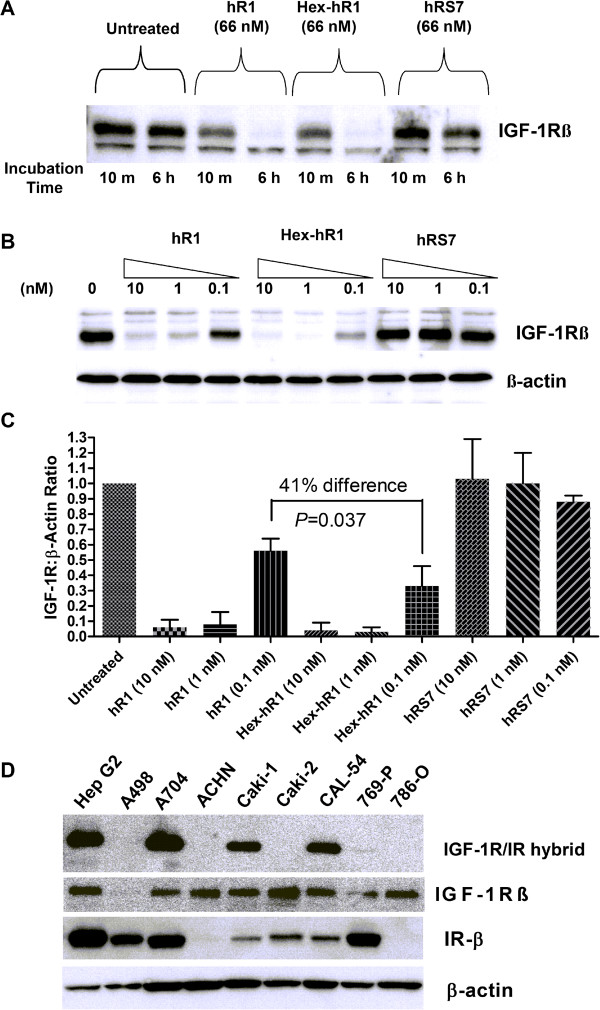
IGF-1R expression. (A) ACHN cells were plated overnight in 6-well plates as described in Materials and Methods. Cells were than exposed to hR1, Hex-hR1, or control hRS7 antibodies before being lysed and 20 μg protein from these lysates subjected to SDS-PAGE (4-20%) followed by blotting with an anti-IGF-1Rβ antibody. IGF-1R time-course down-regulation after exposure to constant amount of either hR1 or Hex-hR1. (B) Cells were exposed to indicated amounts of hR1, Hex-hR1, or hRS7 (anti-Trop-2 antibody) for 6 h before being lysed for Western blotting. β-actin served at the loading control. Blot shown is representative of three repeat experiments. (C) Ratio of IGF-1R to β-actin loading control normalized to untreated cells for the various doses of hR1, Hex-hR1 or control hRS7. Data are shown as mean ± standard deviation. Significance set at P < 0.05 for paired t-test of three experiments. (D) Indicated cells were lysed subjected to immunoprecipitation to determine IGF-1R/IR hybrid receptors, as described in Materials and Methods. A 20-μL aliquot from each immounoprecipitation preparation was subjected to gel eletrophoresis and Western blotting. Hep G2 served as the positive control cell line in these experiments [22]. Blot shown is representative of two repeat experiments. To confirm presence of IGF-1R in IP samples, IP blots were probed with anti-IGF-1R antibody. Additionally, cell lysates were subjected to Western analysis and probed with an anti-IRβ antibody to show relative levels of IR in the various cell lines. β-actin served at the loading control.